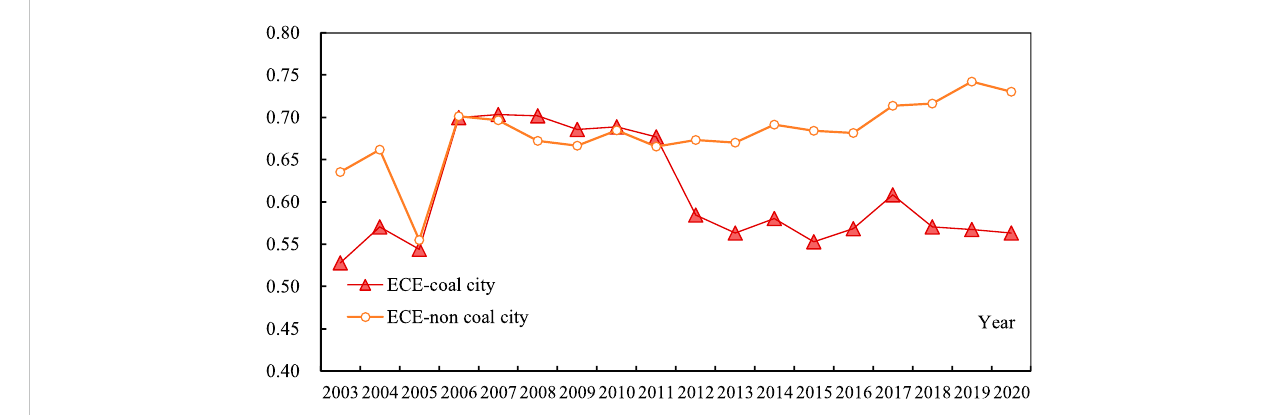
The time changes in the economic ef fi ciency of coal and non-coal cities.